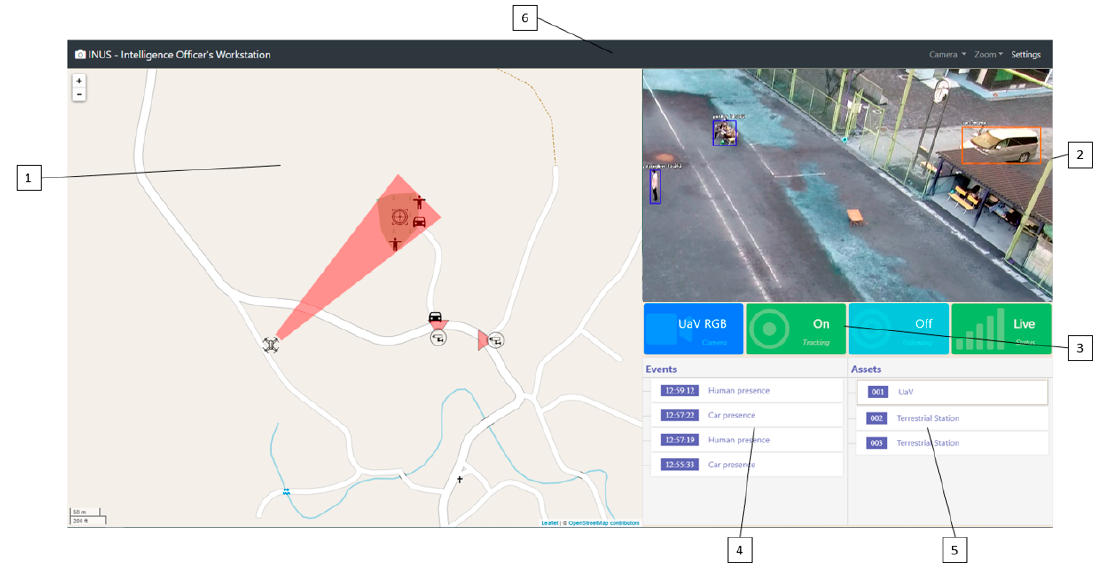
Figure 3. Example snapshot of the User Interface of the intelligence officer’s workstation on the OKUTAMA dataset.